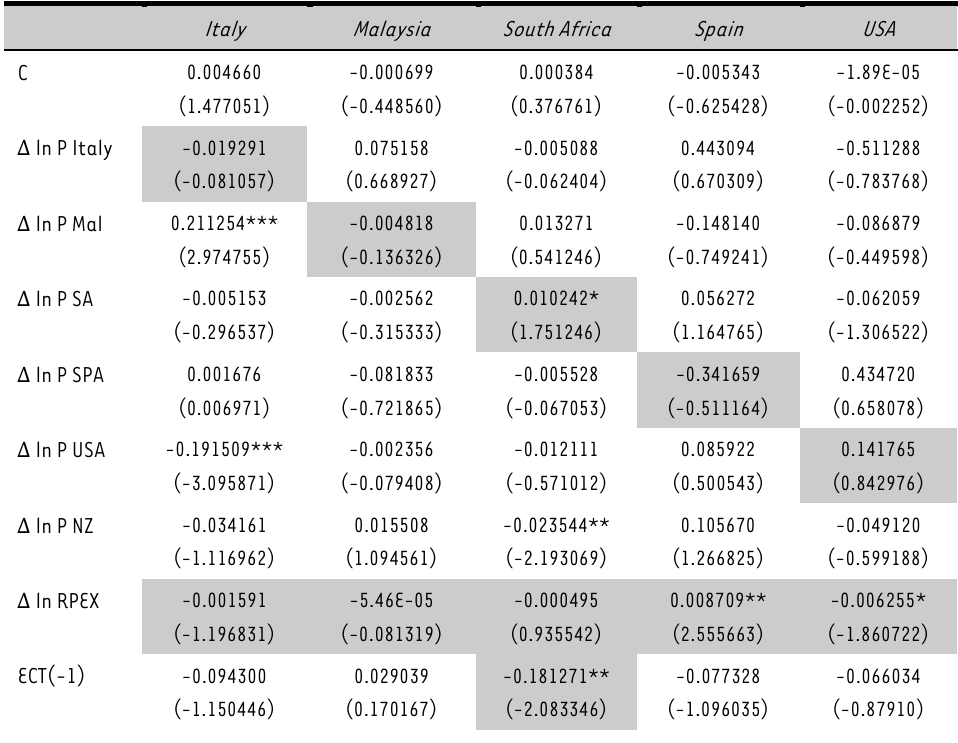
Unrestricted AIDS model for UK